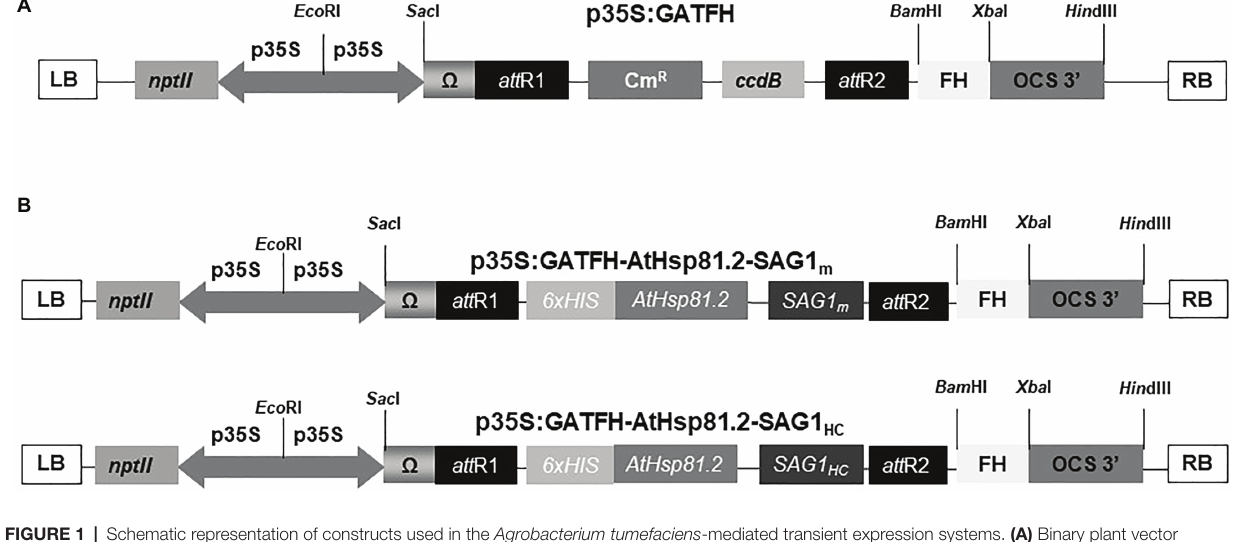
FIGURE 1 | Schematic representation of constructs used in the Agrobacterium tumefaciens -mediated transient expression systems. (A) Binary plant vector p35S:GATFH; (B) AtHsp81.2–SAG1 m and AtHsp81.2–SAG1 HC constructs. p35S, cauliflower mosaic virus (CaMV) 35S promoter; T-OCS, octopine synthase terminator sequence; Ω , translational enhancer sequence; nptII, kanamycin resistance gene; attR1 and attR2, sites of recombination; FH, fumarate hydratase sequence; CmR , chloramphenicol resistance; ccdB , toxin ccdB protein for the E. coli strains; 6x His, six-histidine tag; RB and LB, right and left borders of the T region,